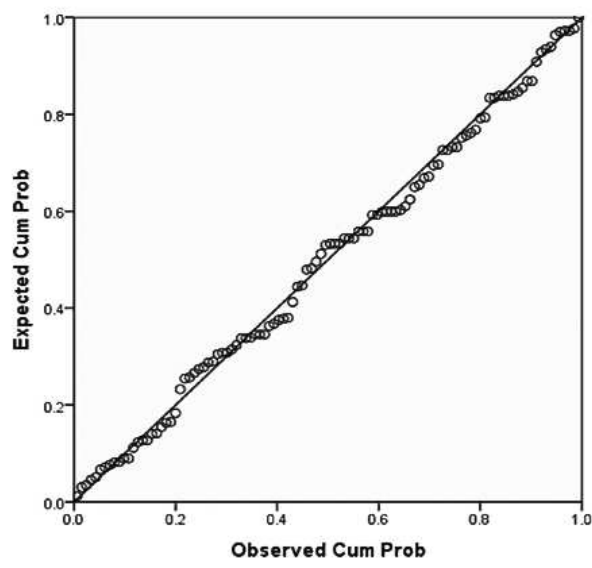
Figure 1. Normal P-P plot: residual